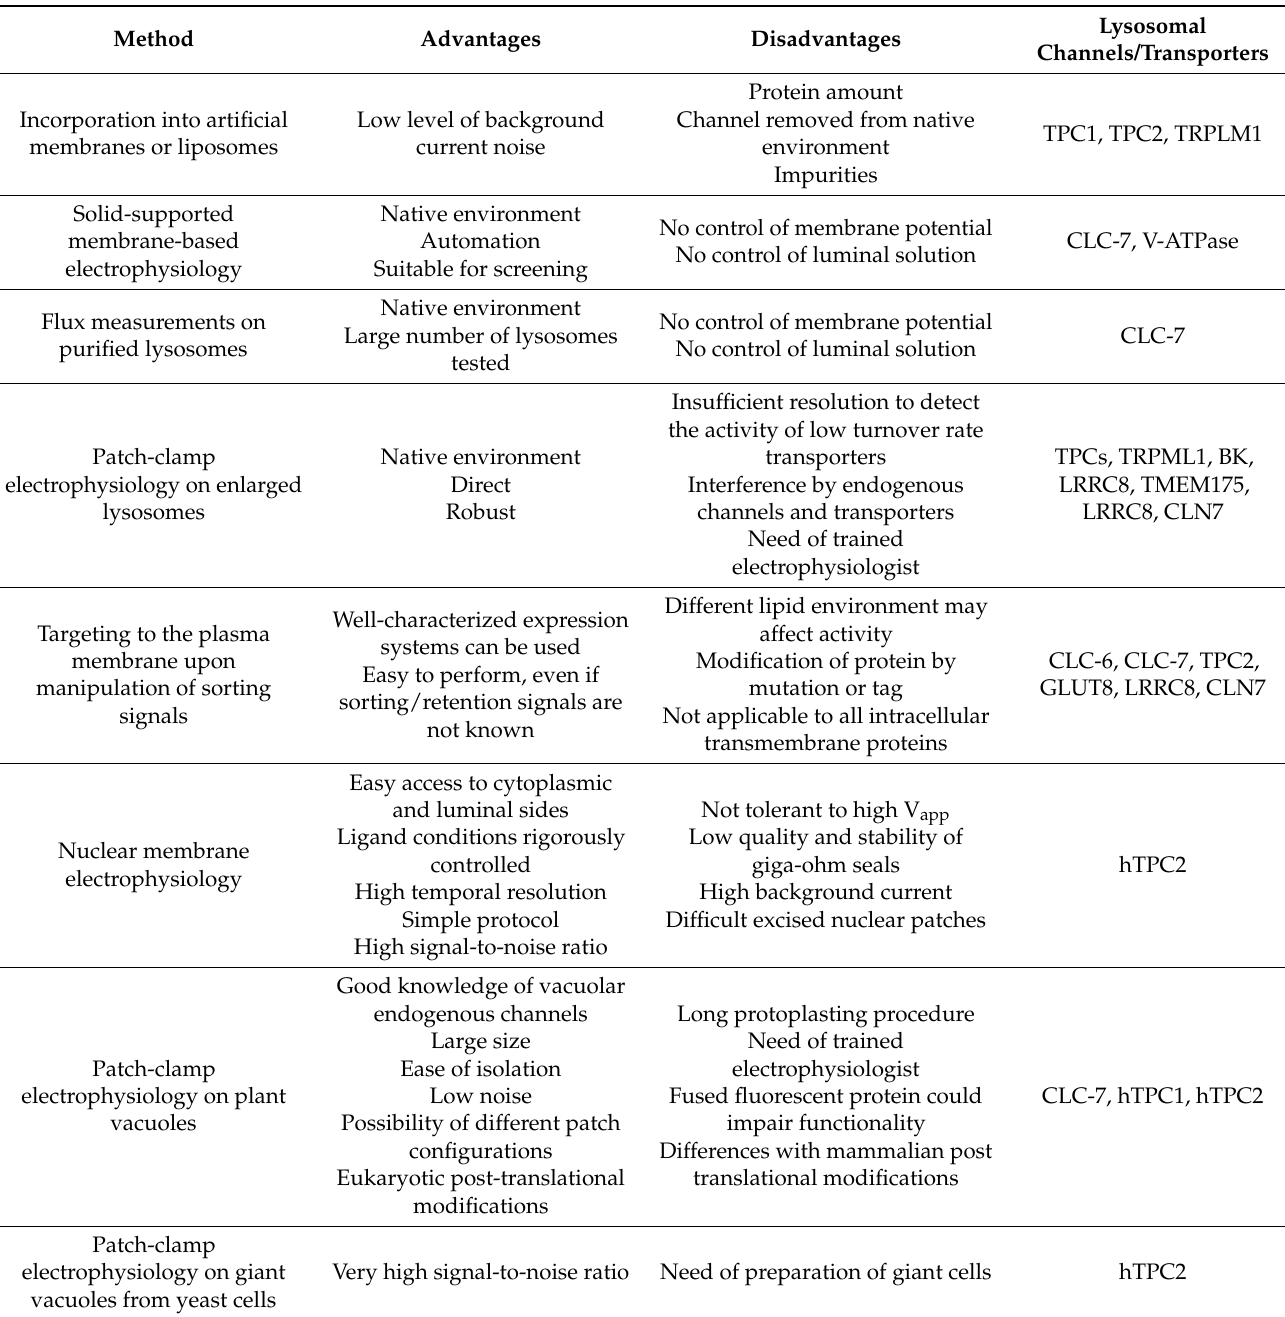
Table 2. Summary of current methods for the functional characterization of endolysosomal channels and